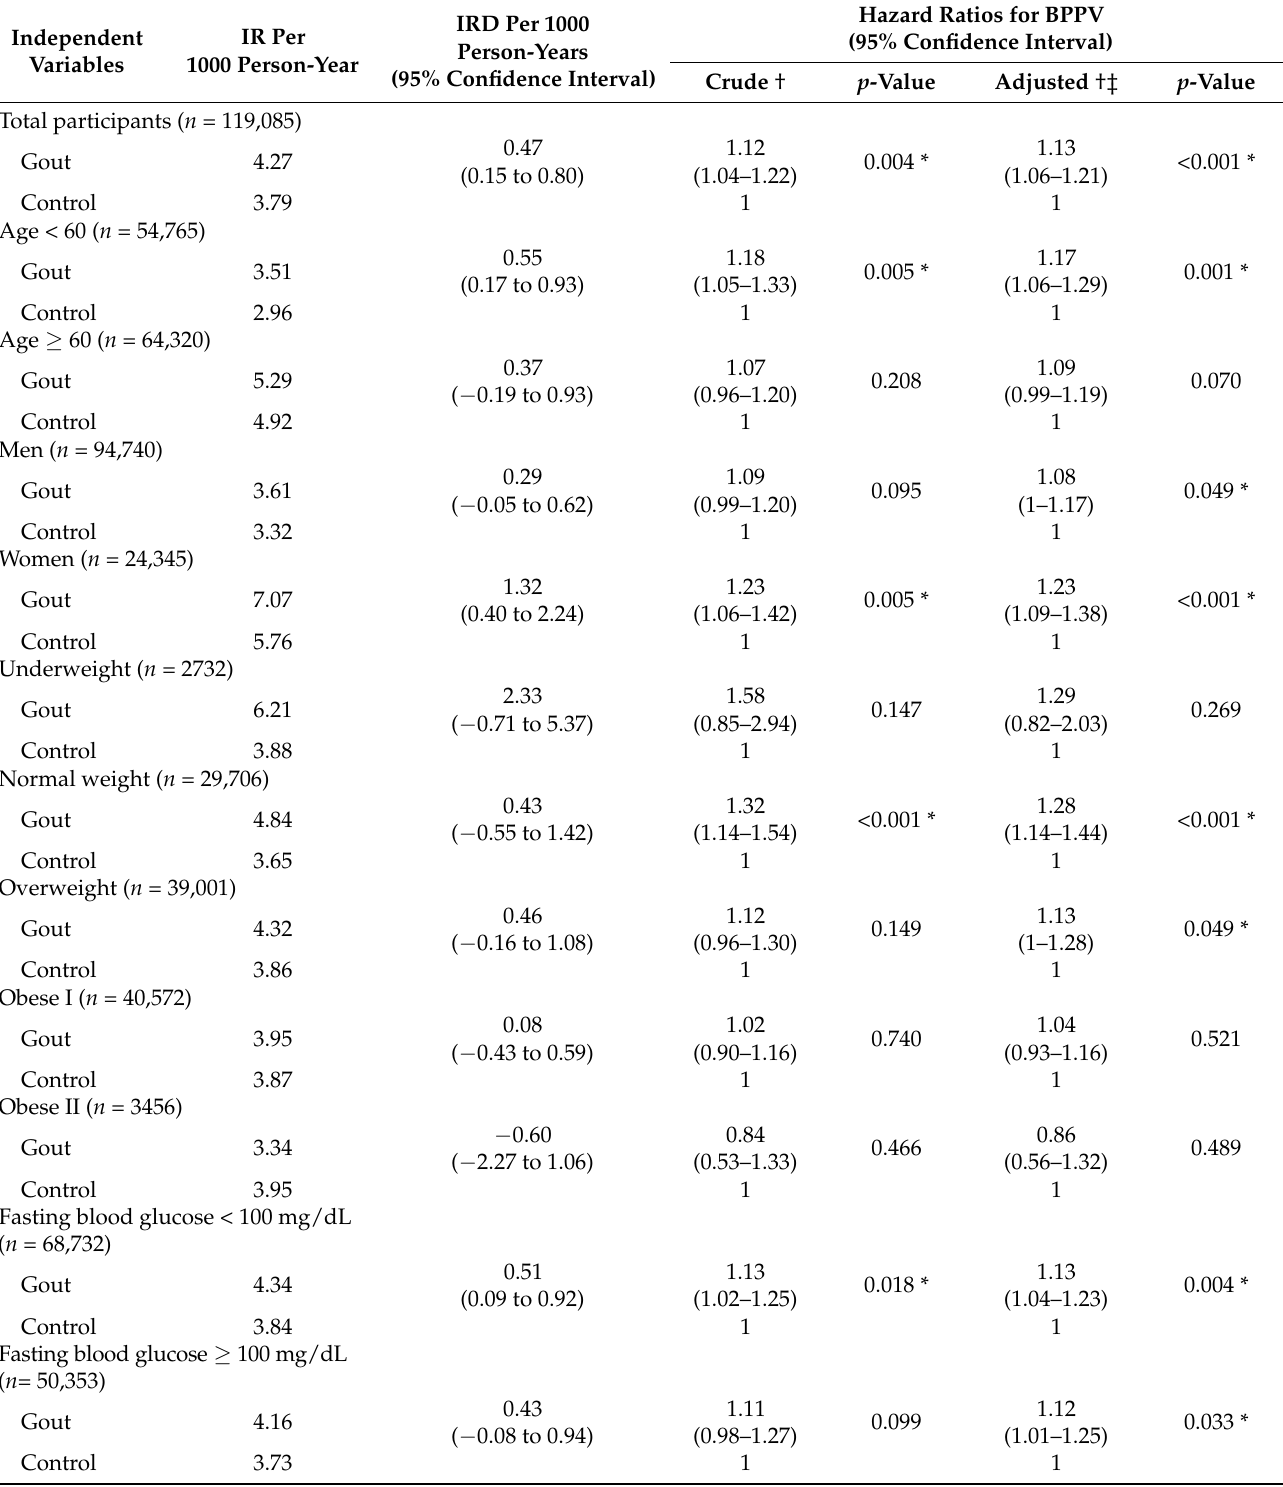
Table 2. Crude and adjusted hazard ratios of Gout for BPPV with subgroups according to age and sex with subgroups according to age, sex, obesity, and fasting blood